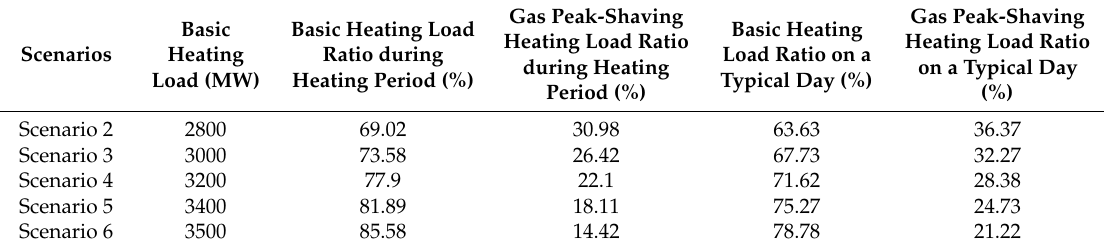
Table 1. Scenario analysis of peak ‐ shaving ratios under different basic heating loads. Table 2. Environmental benefits of the integrated heating system that is replacing the coal-fired